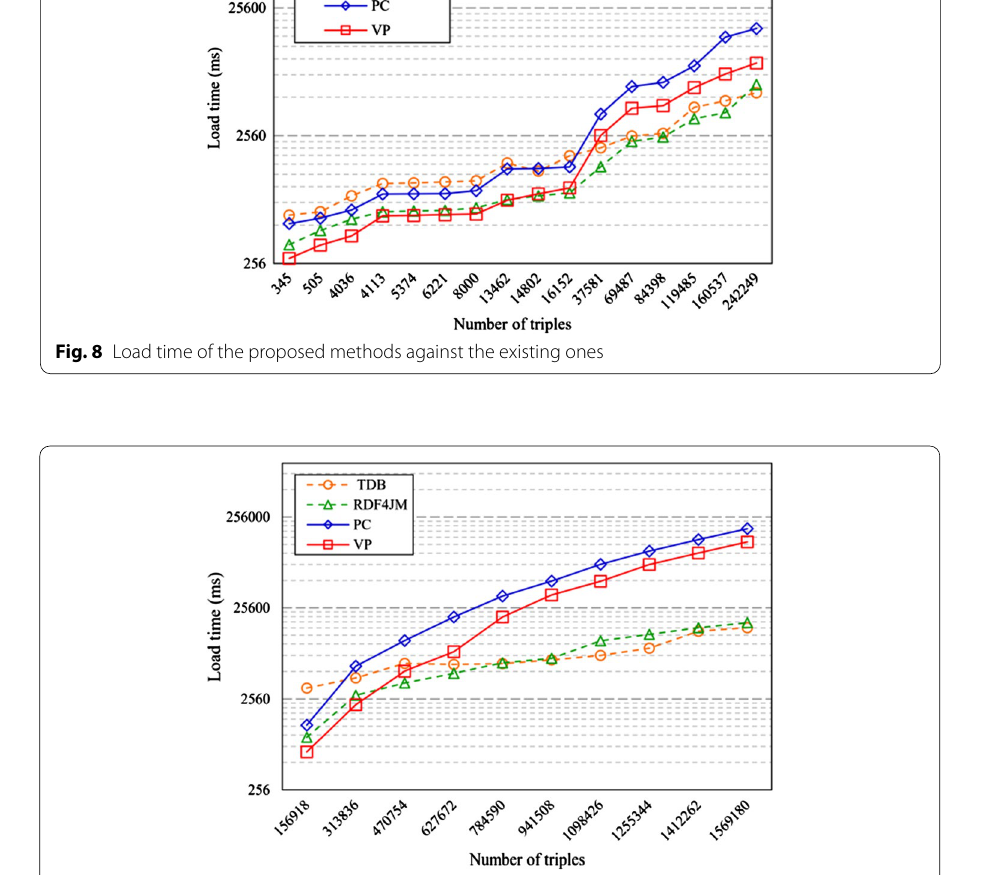
Fig. 9 Comparison of the proposed methods against the existing ones in terms of scalability